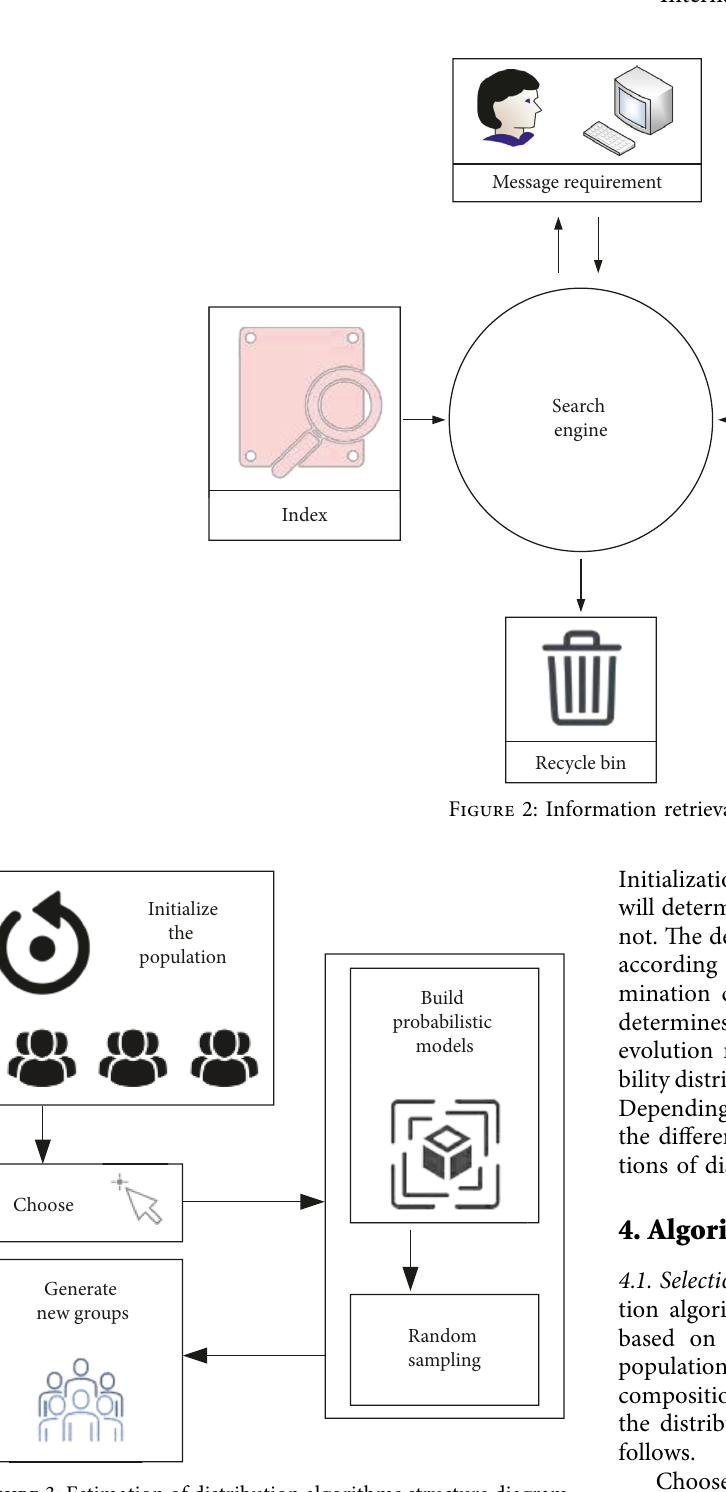
Figure 3: Estimation of distribution algorithms structure diagram.